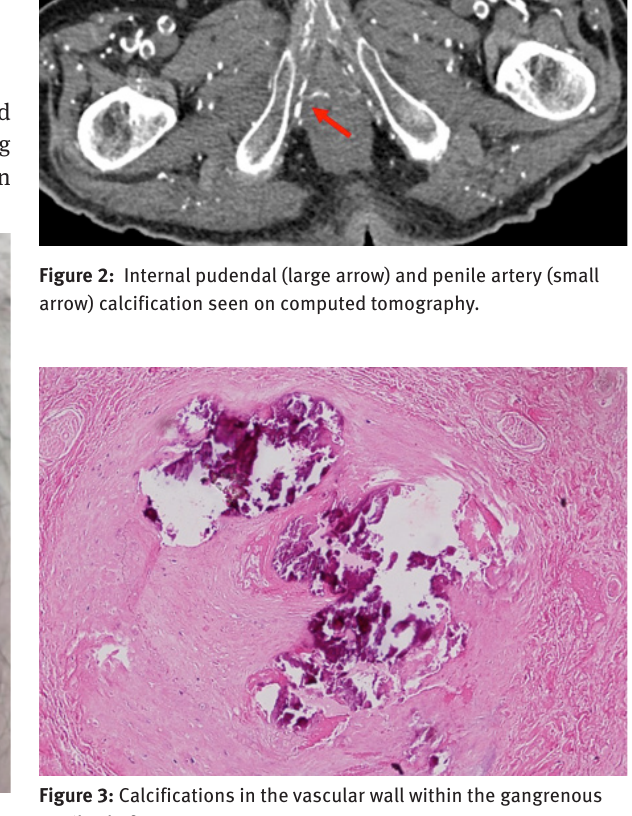
Figure 1: Gangrenous penis.